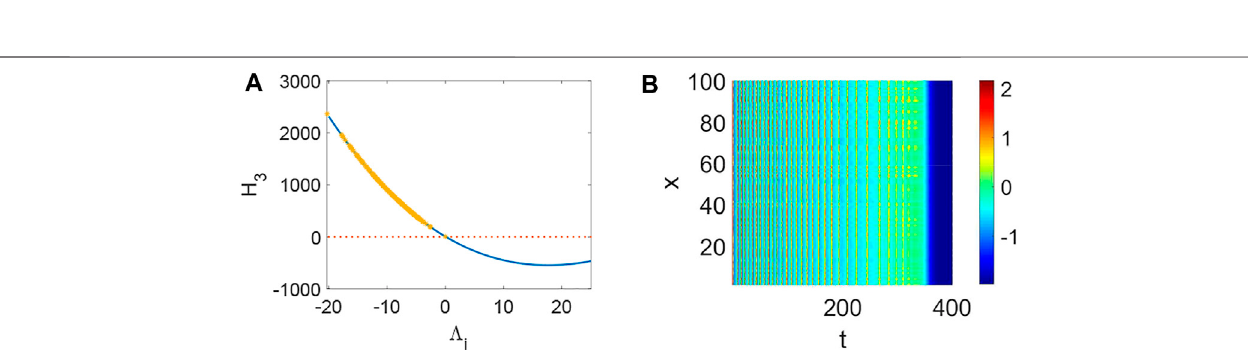
FIGURE 4 | The stability of system (1) when p = 0.5, q = 0.96, τ = 0. (A) The distribution of eigenvalues Λ i (labeled by *). (B) Turing instability occurs in system (1) when a eigenvalue Λ i make H 3 < 0 hold.